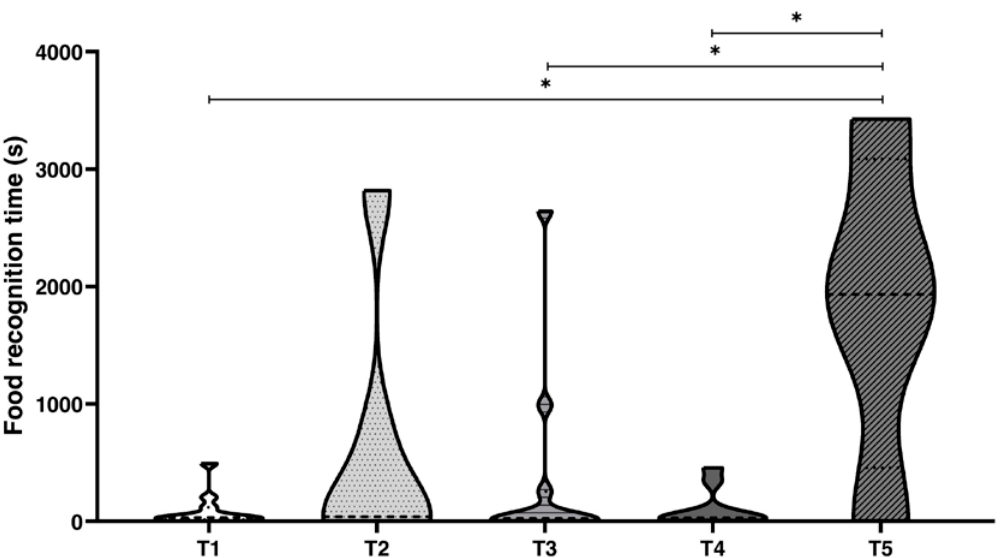
Figure 3. Violin plot of the time spent ( ∆ t) by Octopus vulgaris in problem-solving. T1 combined chemical and visual discriminations; T2 only visual discrimination; T3 only chemical discrimination; T4 real chemical and false visual discriminations; T5 negative control. ∆ t (s): time spent to choose the jar to open, from the very first touch to the grab and wrap of the jar starting to open it. Wilcoxon matched-pairs test vs T1: significance is denoted with asterisks * for p < 0.05.